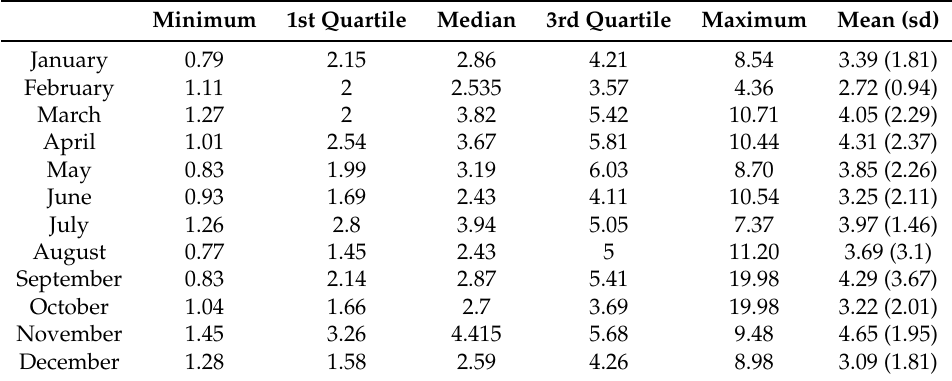
Table 10. Monthly MAPE (in %) on prediction for the FSSM